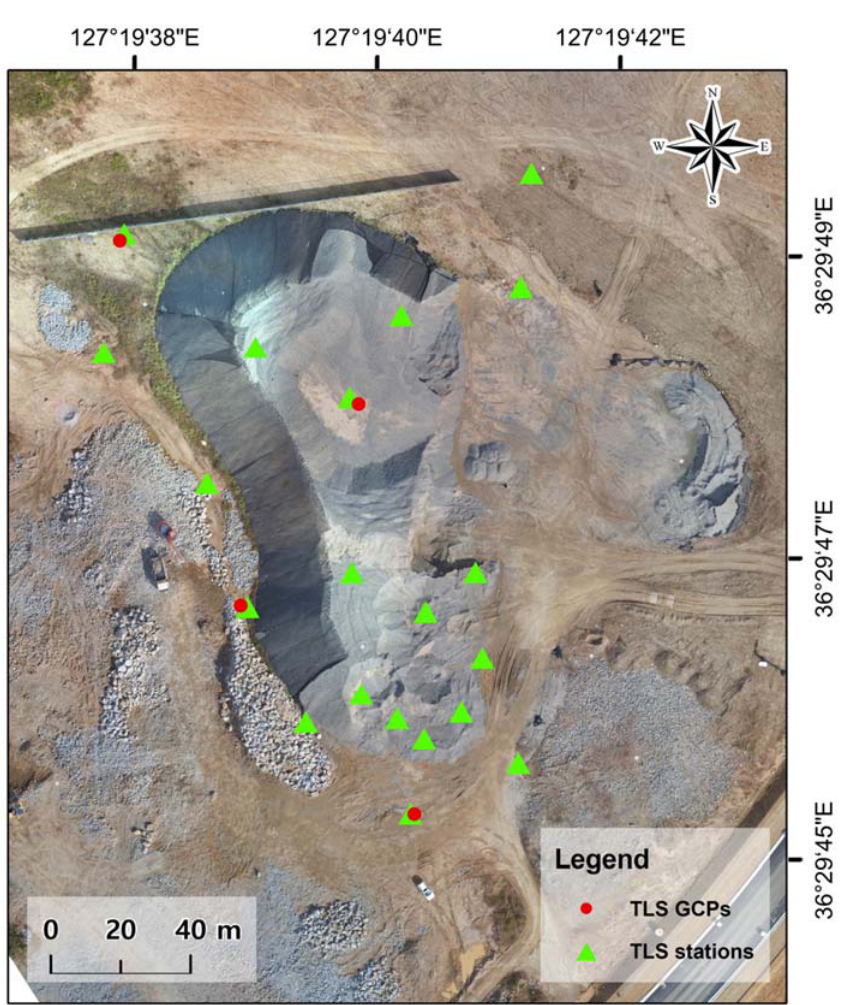
Figure 2. Terrestrial laser scanning (TLS) scan positions and ground control points (GCPs).